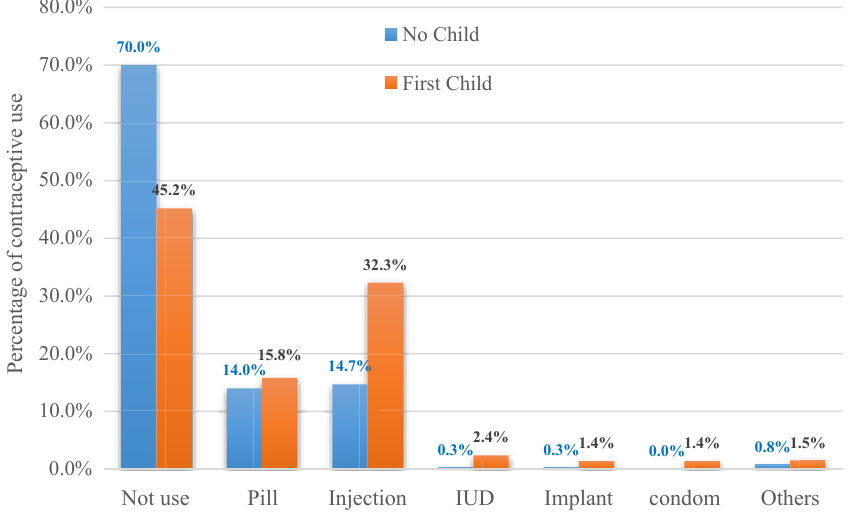
Table III. Predicted probability of the type of marriage by focusing on some selective characteristics